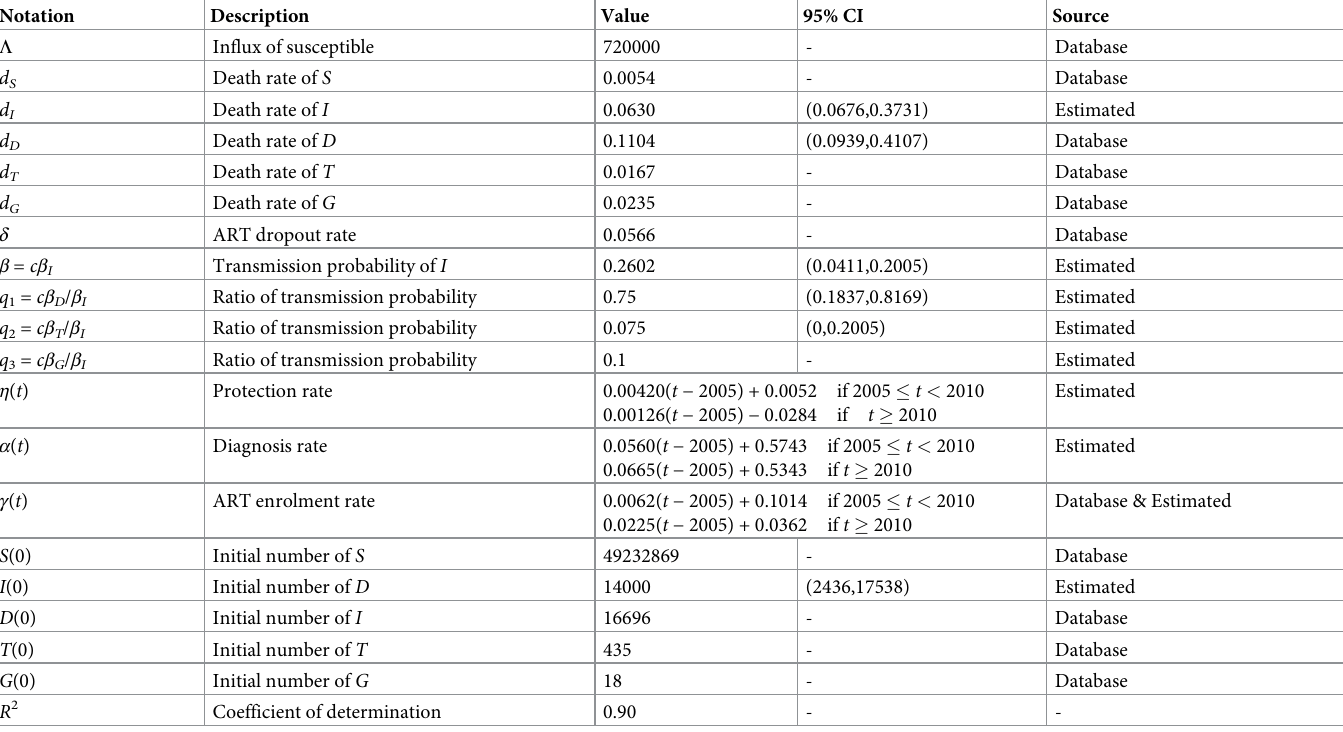
Table 3. Parameter descriptions, values, 95% CI, and sources for mathematical